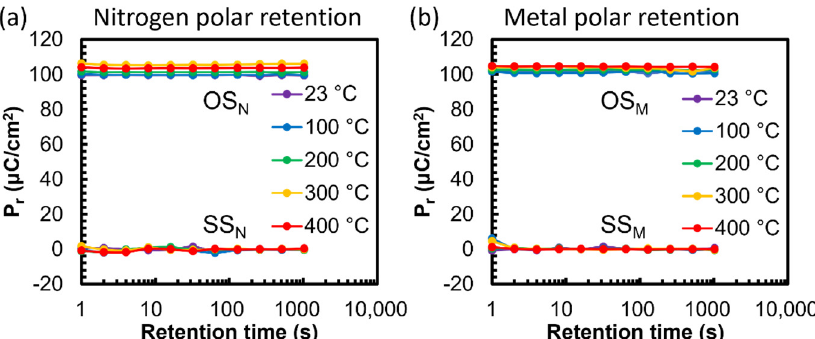
Figure 4. Polarization retention after poling in either ( a ) nitrogen or ( b ) metal surface state and dwelling up to 1000 s at the indicated temperature.